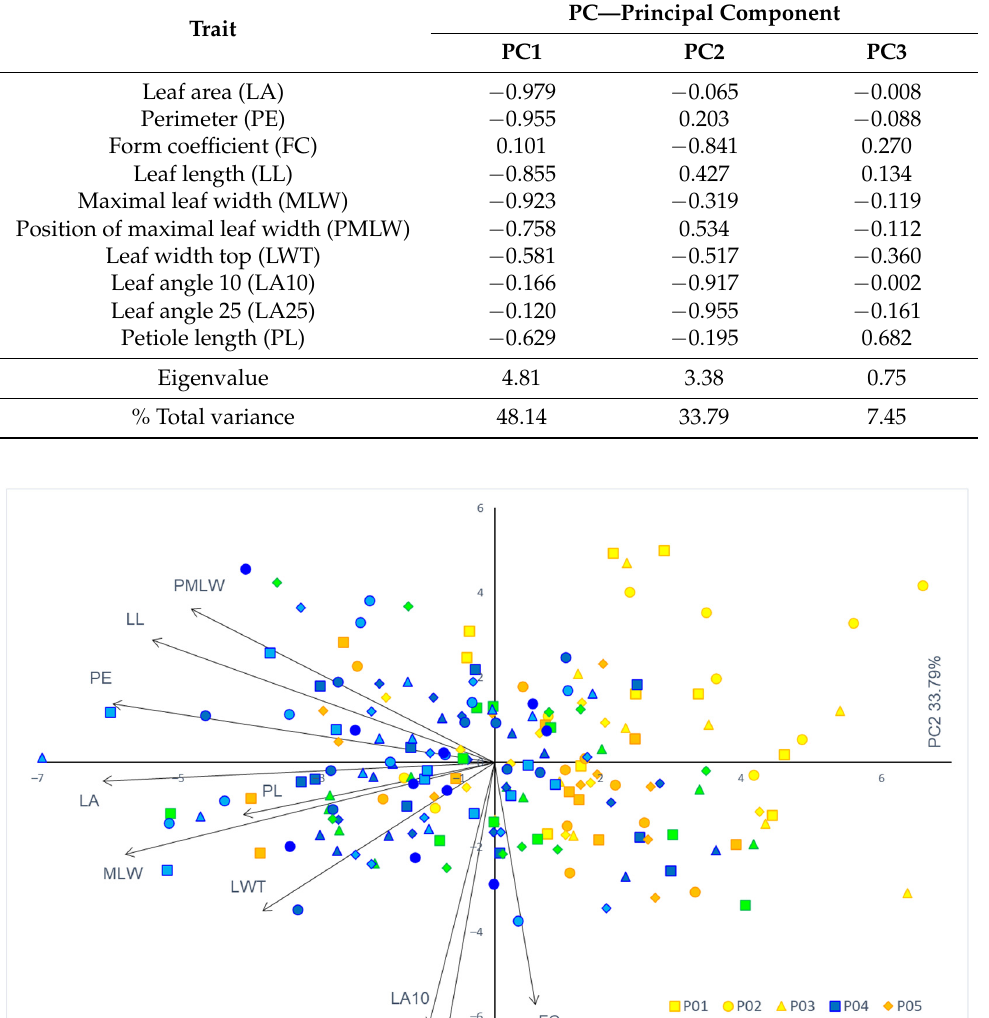
Table 3. Pearson’s correlation coefficients between 10 phenotypic traits and scores of the first three principal components.